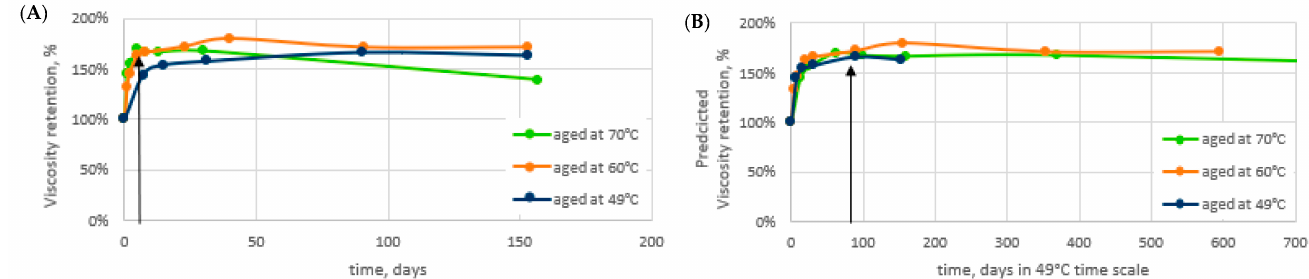
Figure 4. Aging results. Anaerobic 2000 ppm KemSweep A-5265 solutions in Soft. 8 TH RSB brine in the presence of alkali. ( A ) Aging in temperatures of 49 °C (dark blue), 60 °C (orange), and 70 °C (green). ( B ) aging results transferred to corresponding days at 49 °C. Black arrows indicate the point in time for the sampling of aged samples used in the core flood and adsorption testing. Table 6. Summary of concentrations and viscosities used here. Viscosity increases after aging, aver- aging 165%.